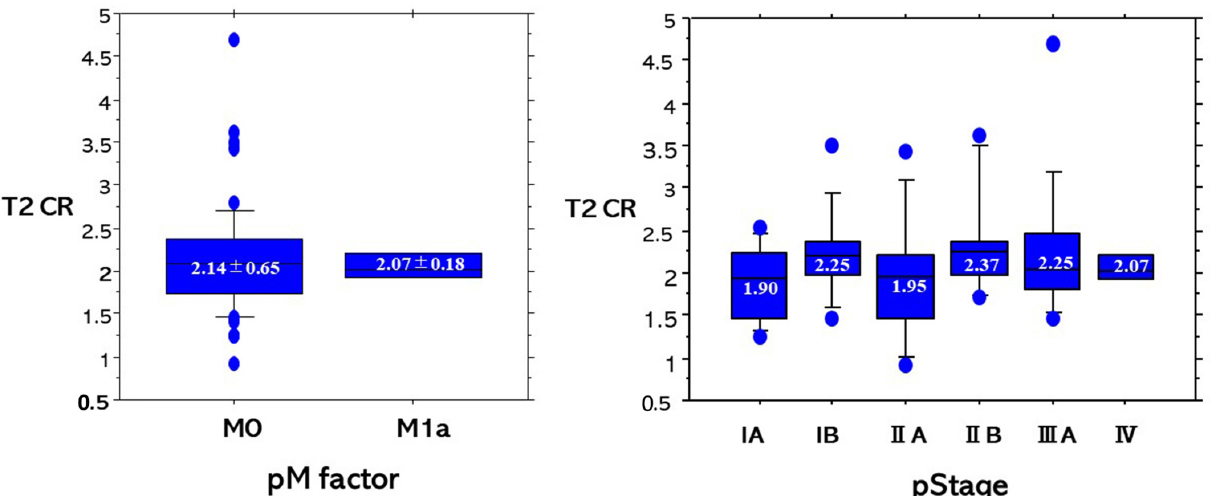
Cancers 2021 , 13 , x FOR PEER REVIEW Figure 6. T2 CR based on pT factors and pN factors. There were no significant differences among T factors or N factors.